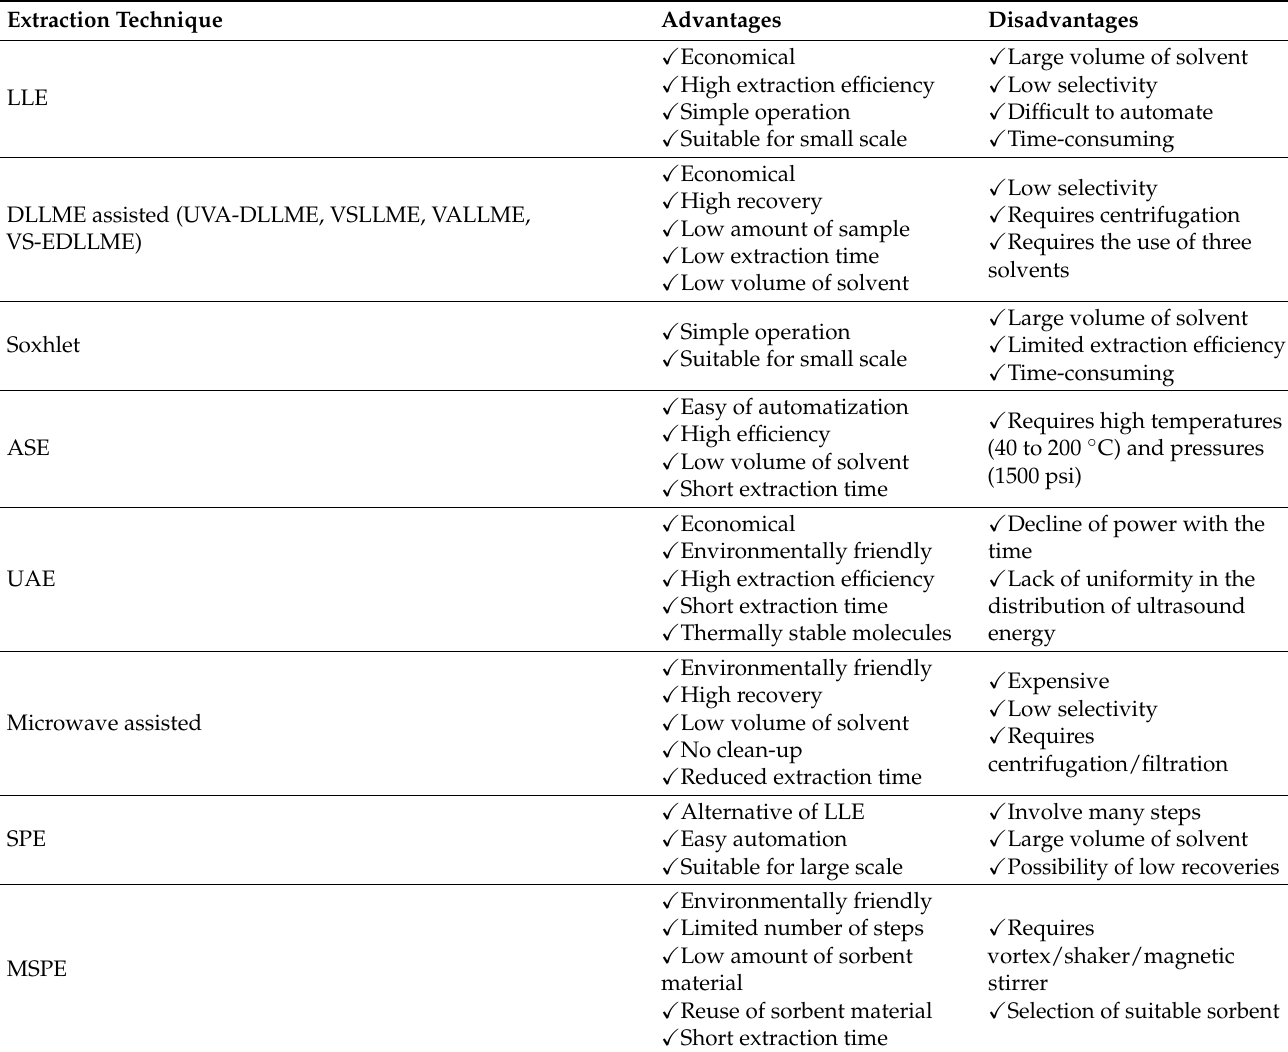
Table 3. Advantages and disadvantages of extraction technique and analytical approaches used for determination of phthalates esters (PAEs) in environmental and food samples. Extraction Technique Advantages